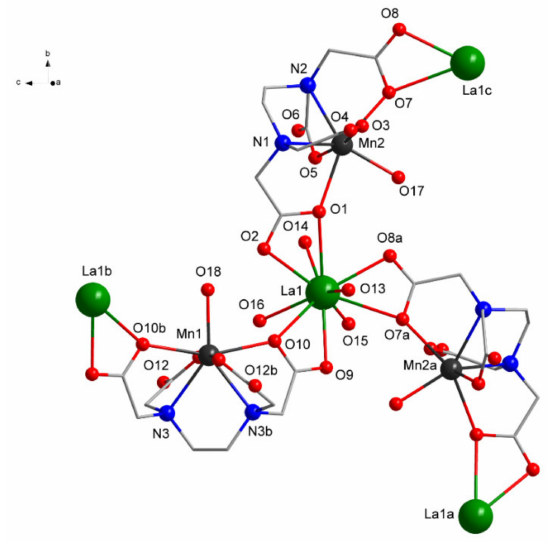
Figure 3. View of the coordination environments of La III and Mn II ions in 1 (H atoms and free water molecules omitted for clarity; symmetry equivalent atoms (3 / 2 − x, − 1 / 2 + y, − z), (2 − x, y, 1 − z), and